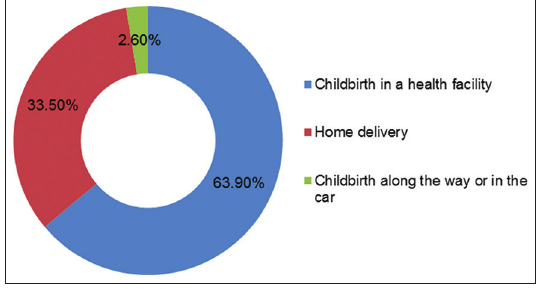
Figure 2 : Distribution of maternal deaths in Dori hospital based on the vaginal delivery site, 2014-2016 (n =